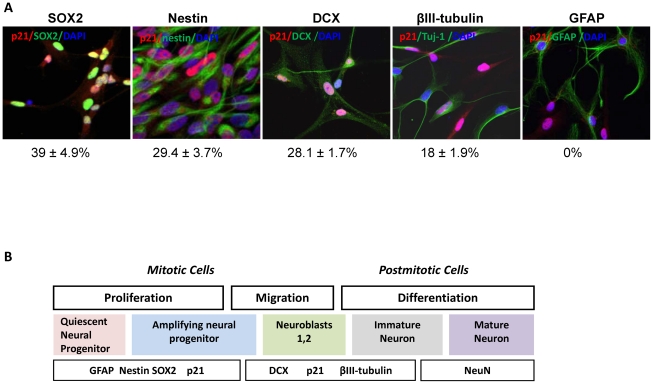
p21 is expressed in hippocampal NPC of a neuronal lineage.Cultured neuronal progenitors were stained for p21 (intranucelar, red) and various neuronal markers. A) co-localization of p21 and SOX2 (green, intranuclear, double-positive nuclei appear yellow; B) co-localization of p21 and nestin (green, cytoplasmic); In differentiating NPC, p21 co-localizes with C) DCX (green, cytoplasmic); and with D) Tuj-1 (green, cytoplasmic), but not with E) GFAP (green, cytoplasmic). Numbers indicate the percentage of p21-positive cells among the total number of cells expressing a respective marker. Counting was performed in triplicate (>500 cells per sample). Data are presented as mean ± SEM.